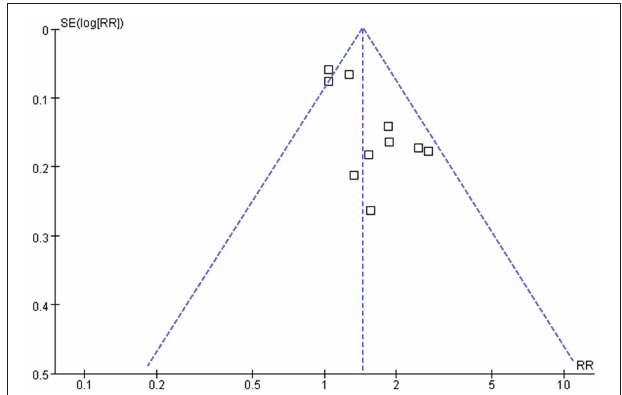
FIGURE 5 | Funnel plots for the publication bias underlying the meta-analysis of the association between TyG index and hypertension in community-derived adult